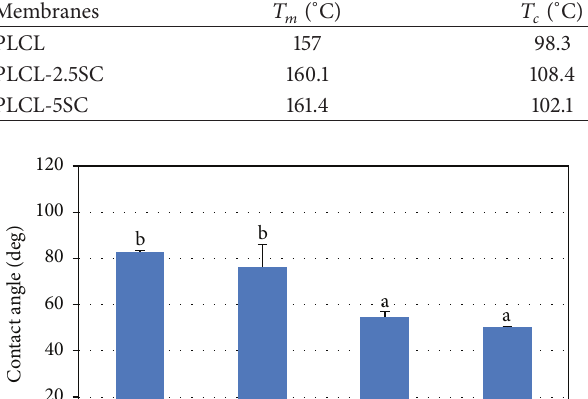
Table 4: DSC thermogram from the membranes. Membranes